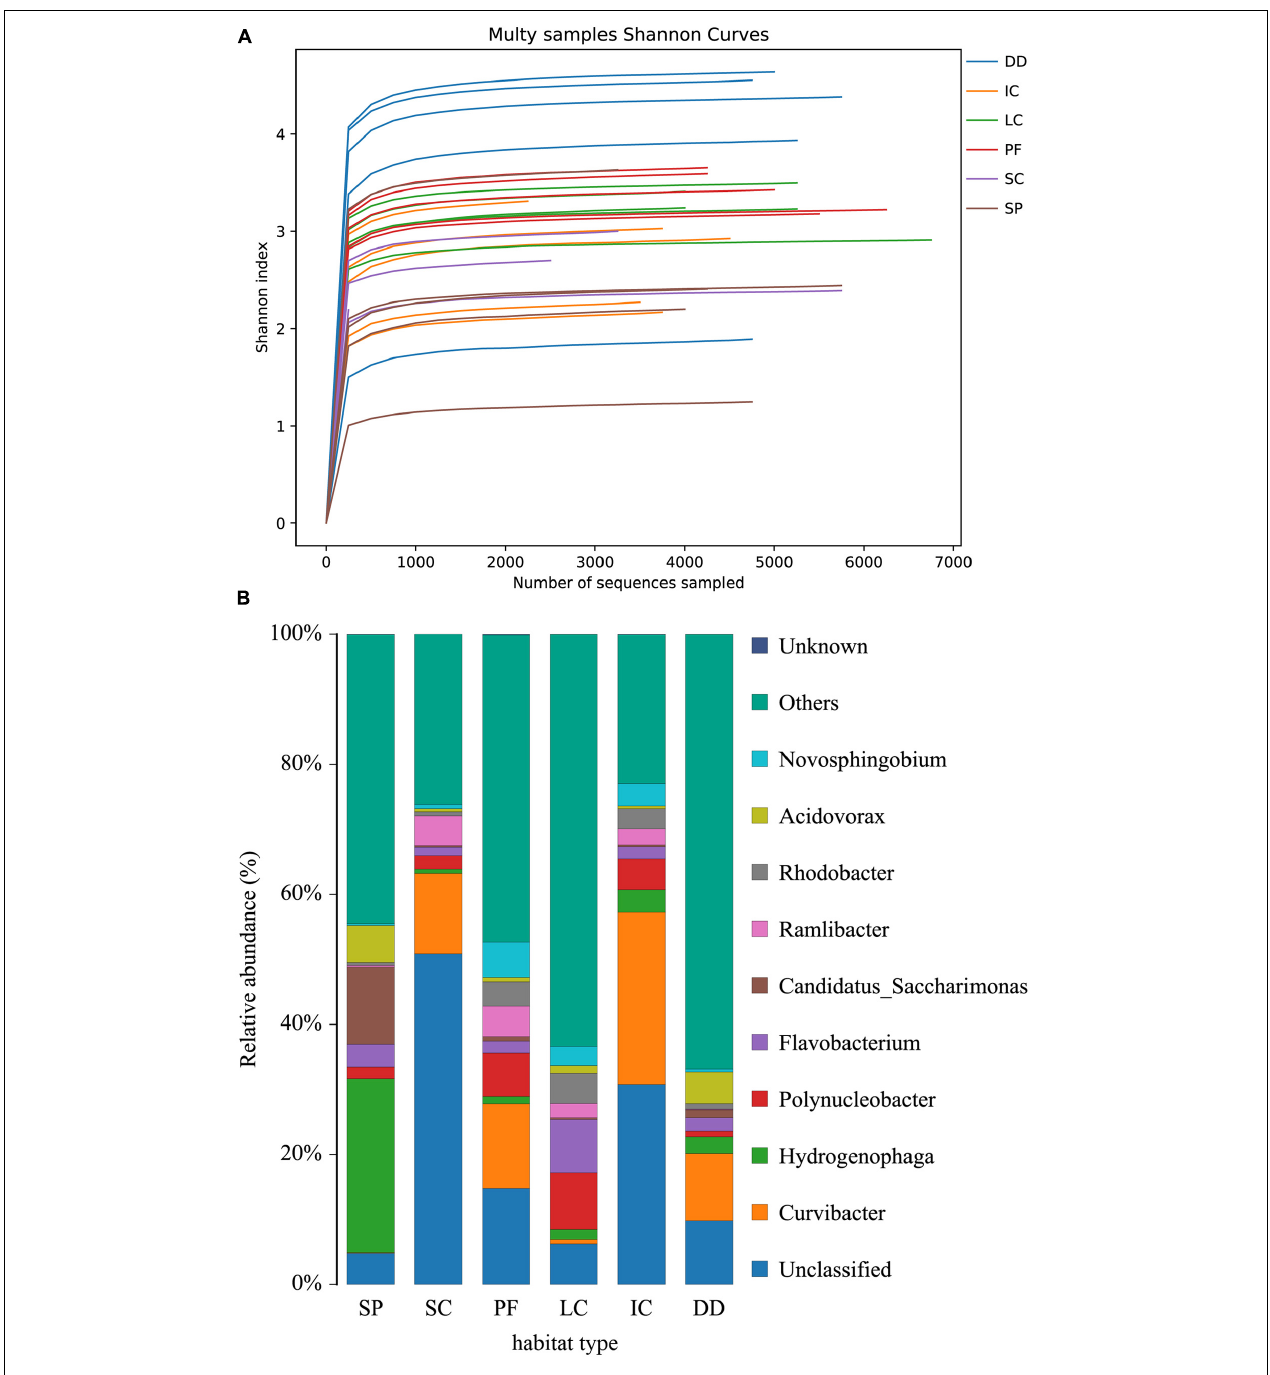
FIGURE 4 | Alpha diversity analysis: (A) Shannon diversity index dilution curve. It shows the microbial diversity of each sample at different sequencing quantities. The curve is flat, indicating that the sequencing quantity is large enough, and the results of Shannon index accurately reflected the real situation of the samples. (B) The top-ten species at the richness level in each habitat. DD, drainage ditches; IC, irrigation channels; LC, large water containers; PF, paddy fields; SC, small water containers; SP, small puddles.